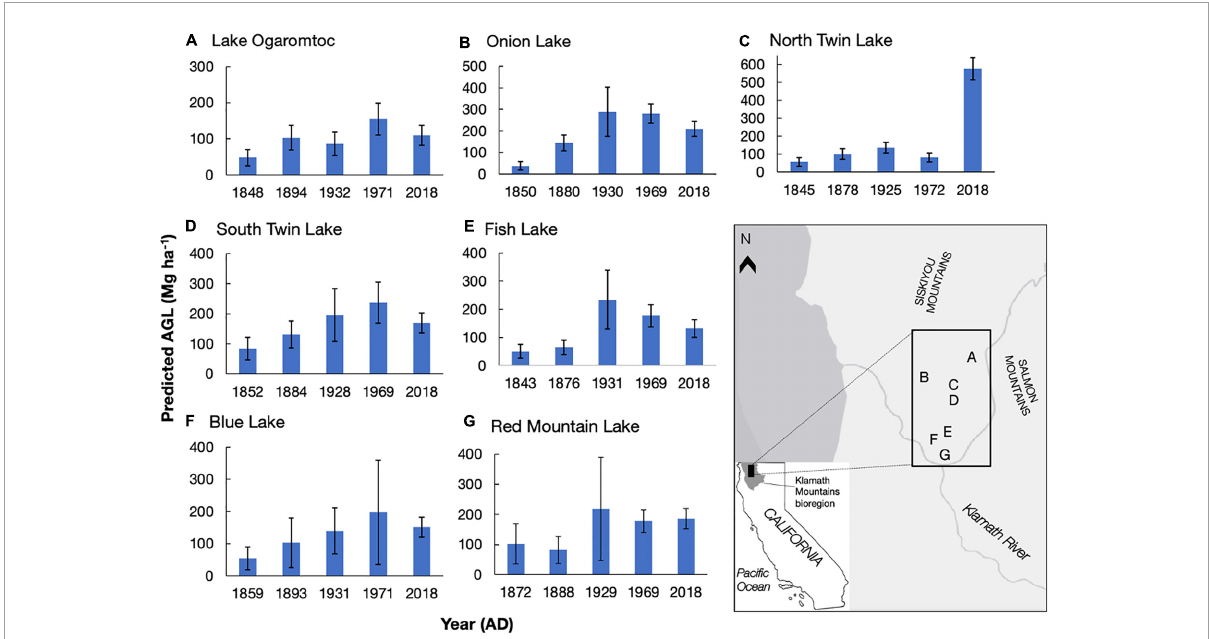
FIGURE1 Predicted aboveground live tree biomass (AGL, Mg ha − 1 ) for seven lake sites (A–G) at five time periods in the Klamath bioregion, California. AGL means and standard errors (calculated from uncertainty analysis) reported. Letters A-G correspond to the lake and its location on the map. Ages (year AD) were modeled from 210 Pb dating presented in Knight et al. (2021) and reflect the mean age for that sampled cm. Biomass estimates reflect an area of ∼ 650 m around each lake site. Copyright © 2022 Esri and its licensors. All rights